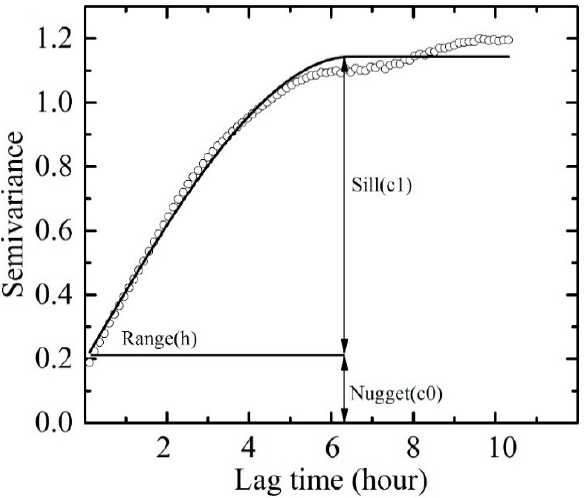
Figure 3. A spherical semivariogram showing range ( a ), sill ( c ) and nugget ( c 0 ). The dots represent experimental data and the solid line represents the model fit.